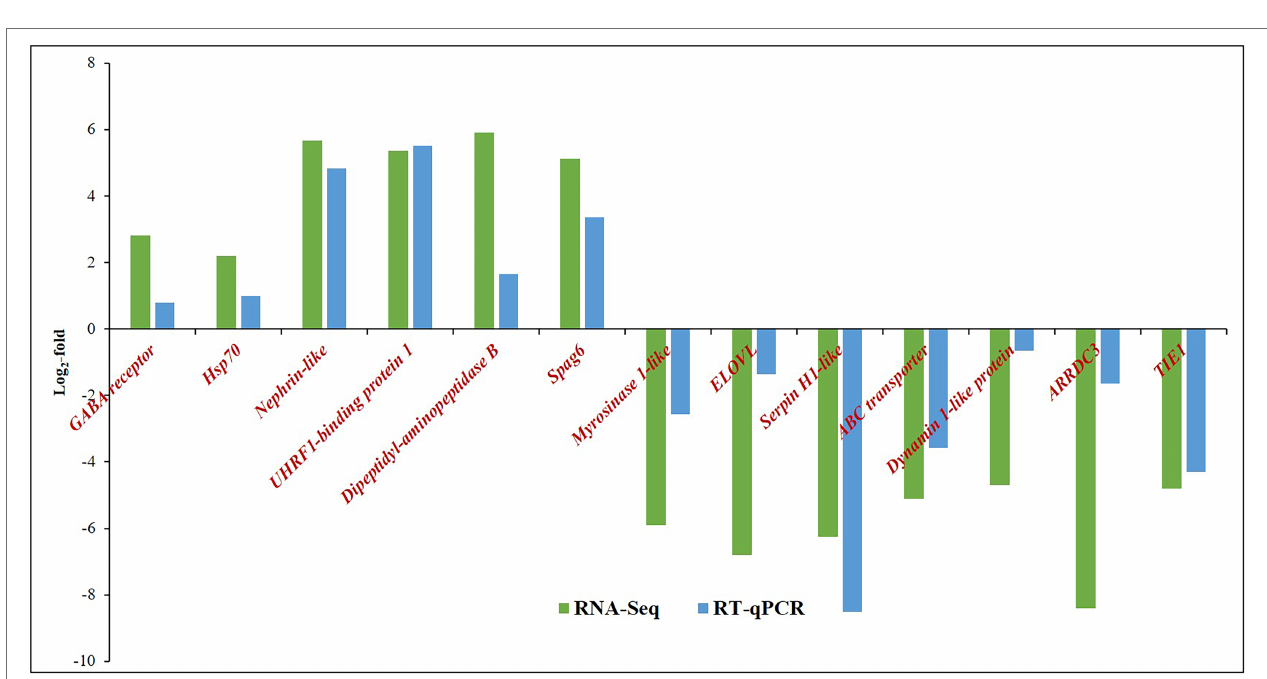
FIGURE 5 | Expression of Thrips palmi putative genes in response to GBNV infection in RNA-Seq and reverse transcriptase-quantitative real-time PCR (RT-qPCR). The values of log 2 -fold changes calculated in RNA-Seq analysis were in accordance with the RT-qPCR fold change values. Pearson’s correlation coefficient value was 0.81 as calculated using the CORREL function in MS